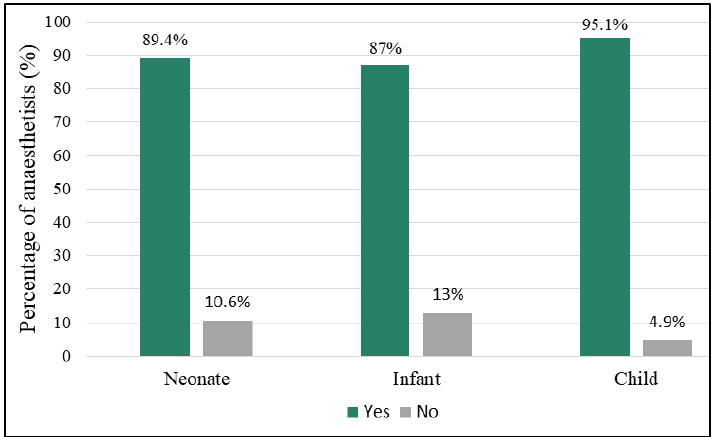
Figure 3. Preoxygenation during RSI.